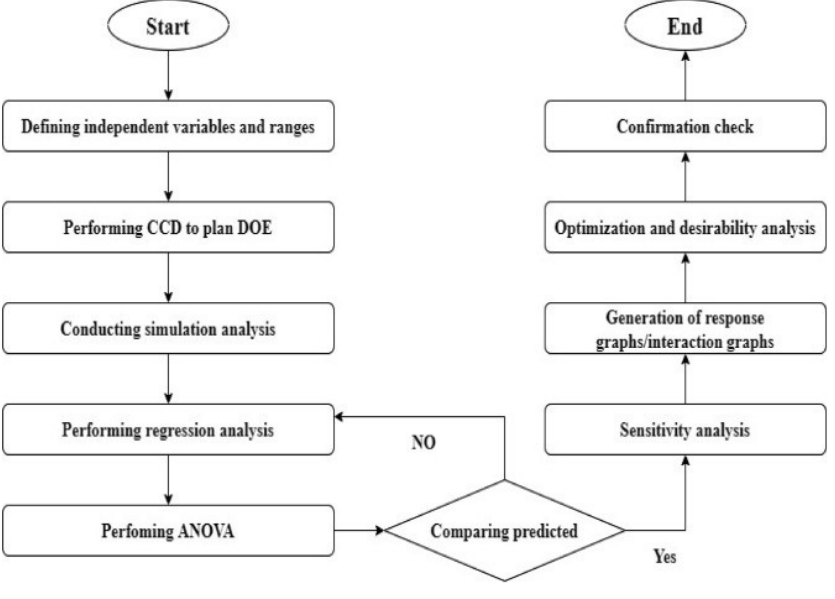
Figure 4. Response surface methodology approach [54].